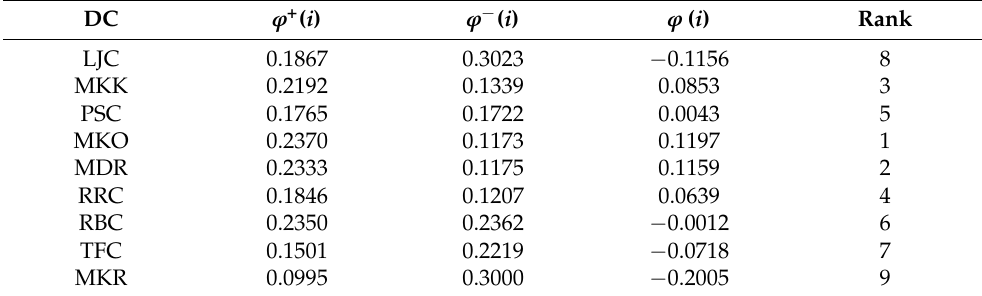
Table 2. Leaving flow, entering flow, and the final PROMETHEE II-based ranking of the DCs.